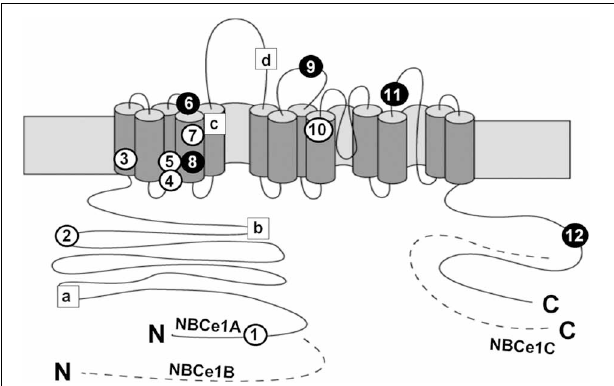
FIGURE 1 | Topological model and mutations of NBCe1. Circles show the localization of the following pRTA-related mutations: Q29X (1), R298S (2), S427L (3), T485S (4), G486R (5), R510H (6), W516X (7), L522P (8), 2311 delA (9), A799V (10), R881C (11), and S982NfsX4 (12), where black circles indicate the association with migraine. Squares show the localization of the following SNPs: E122G (a), S356Y (b), K558R (c), and N640I (d). The dashed segments represent the specific regions of NBCe1-B or NBCe1-C; N and C denote the N- and C-termini, respectively.